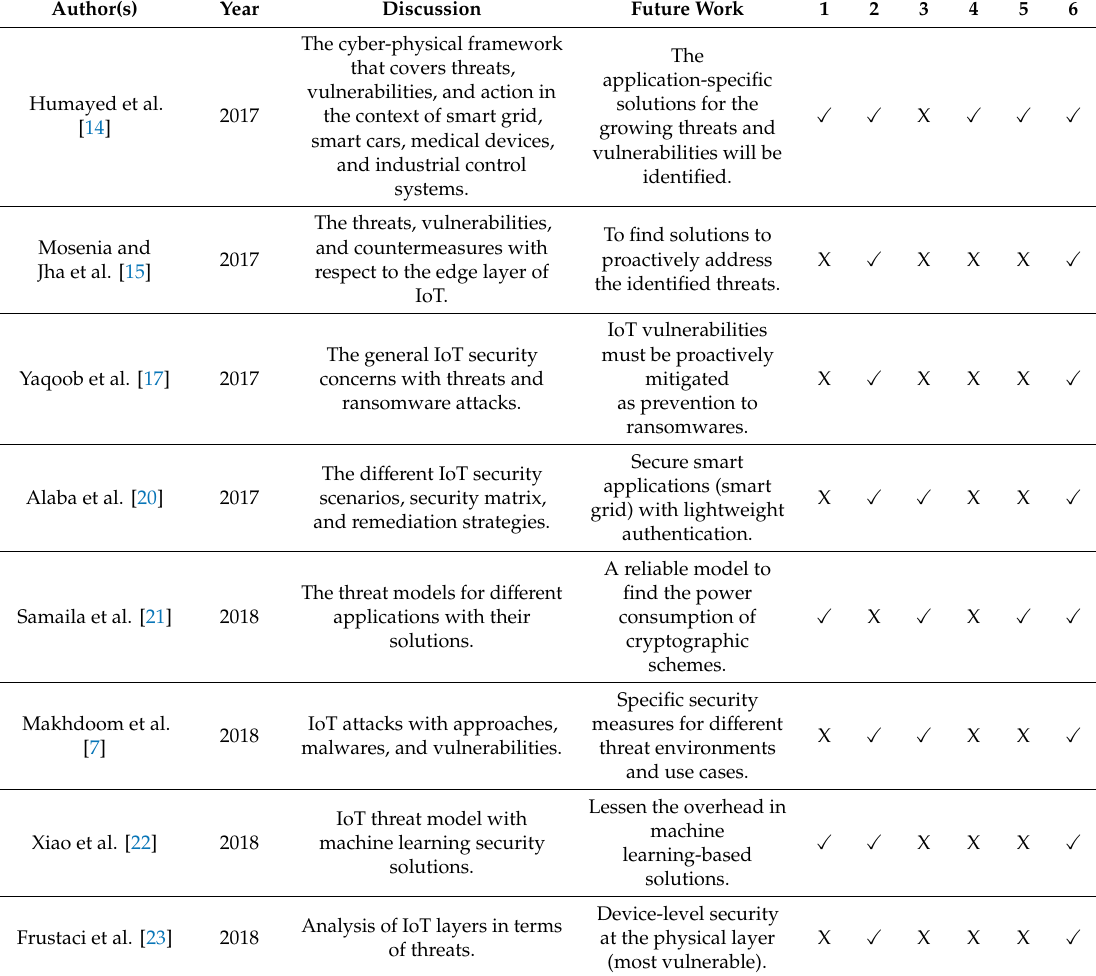
Table 1. A relative comparison of the proposed work with state-of-the-art